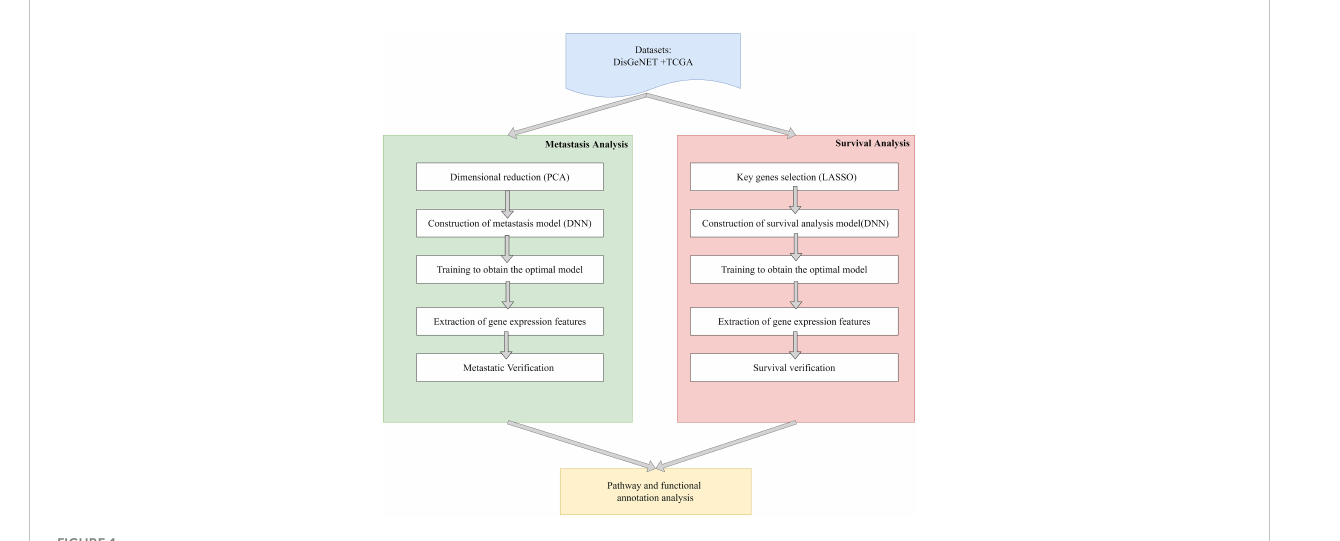
FIGURE 1 Work fl ow of